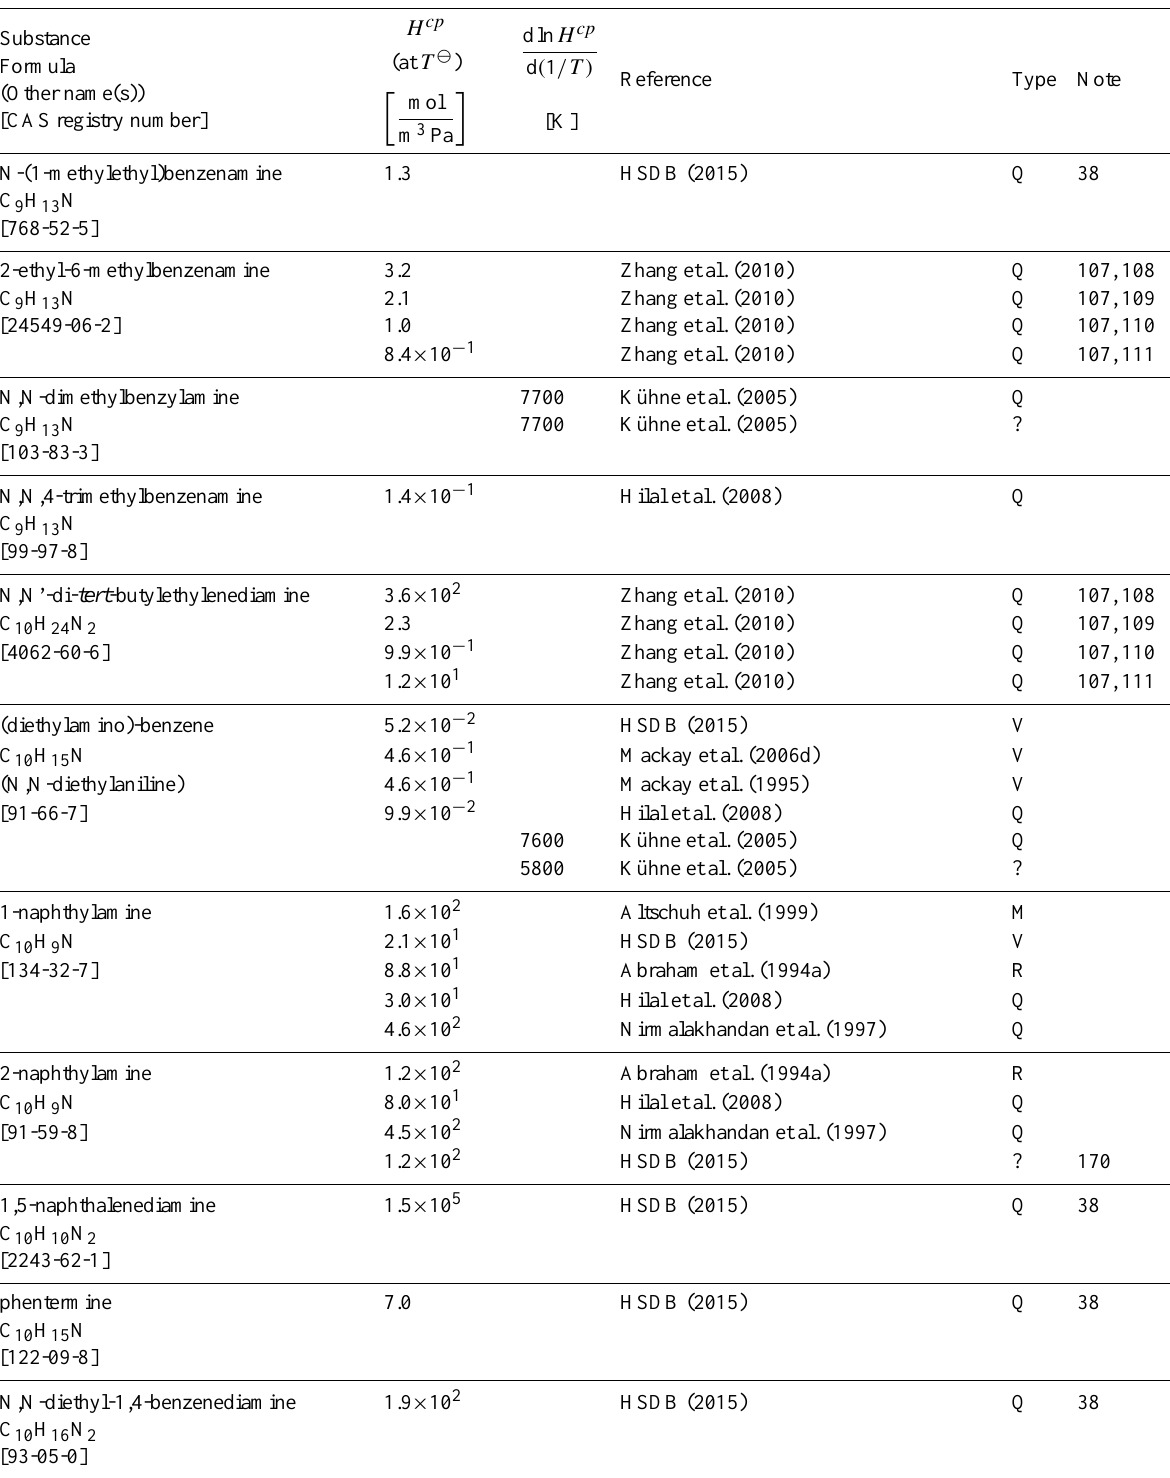
Table 6: Henry’s law constants for water as solvent